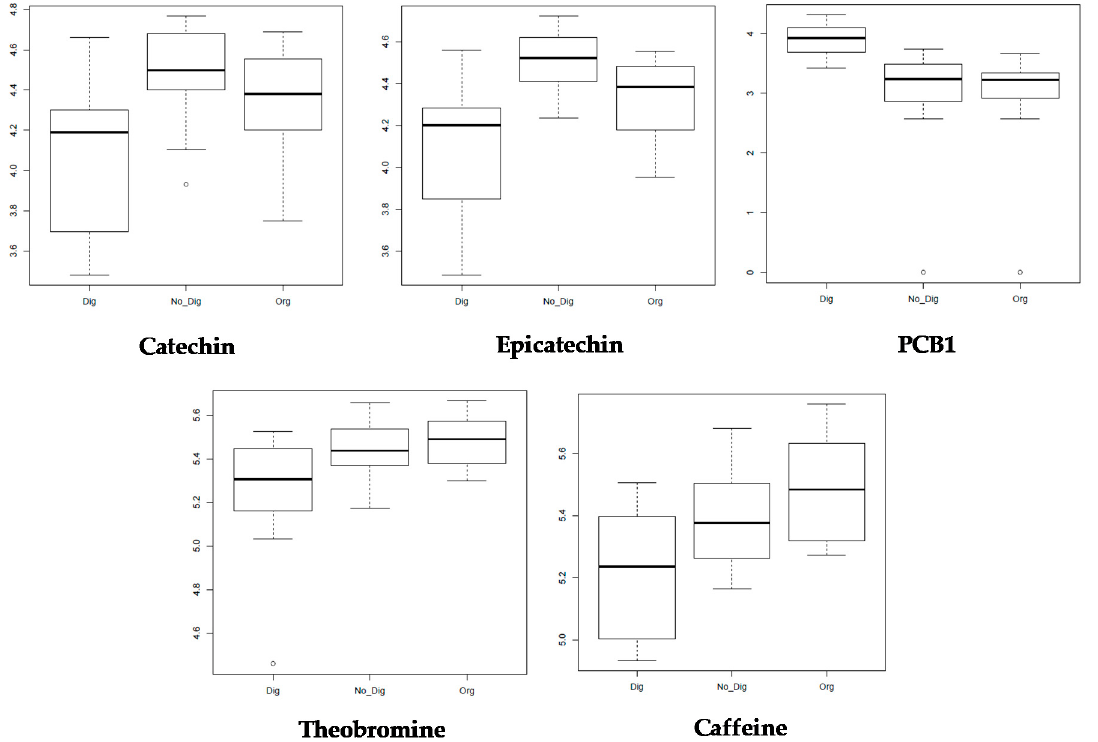
Figure 3. Boxplot of the log 10 -intensities of catechin ( m/z = 291.1070, t = 497 s), epicatechin ( m/z = 291.0969, t = 585 s), PCB1 ( m/z = 579.2428, t = 378 s), theobromine ( m/z = 181.3165, t = 371 s), and caffeine ( m/z = 195.2854, t = 491 s) for the three types of extraction for the whole sample set (ANOVA, p < 0.05).